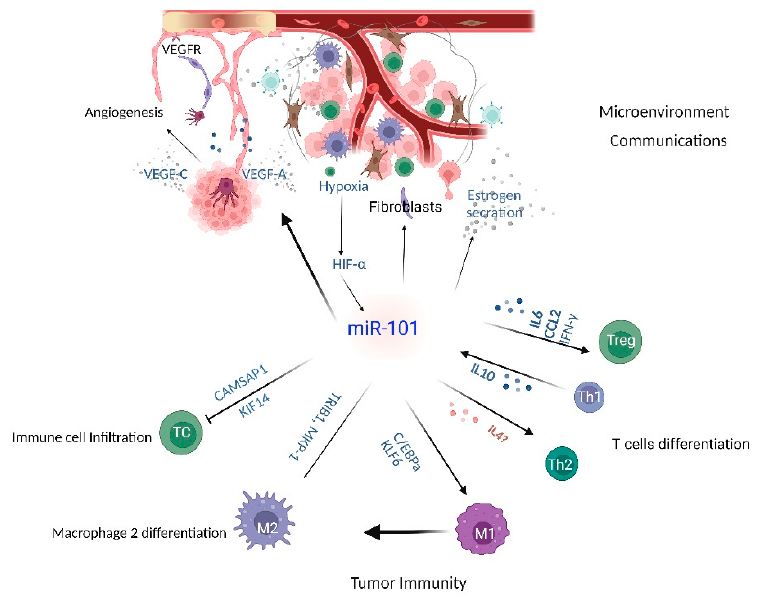
Figure 2. MiR-101 in context: tumor microenvironmental